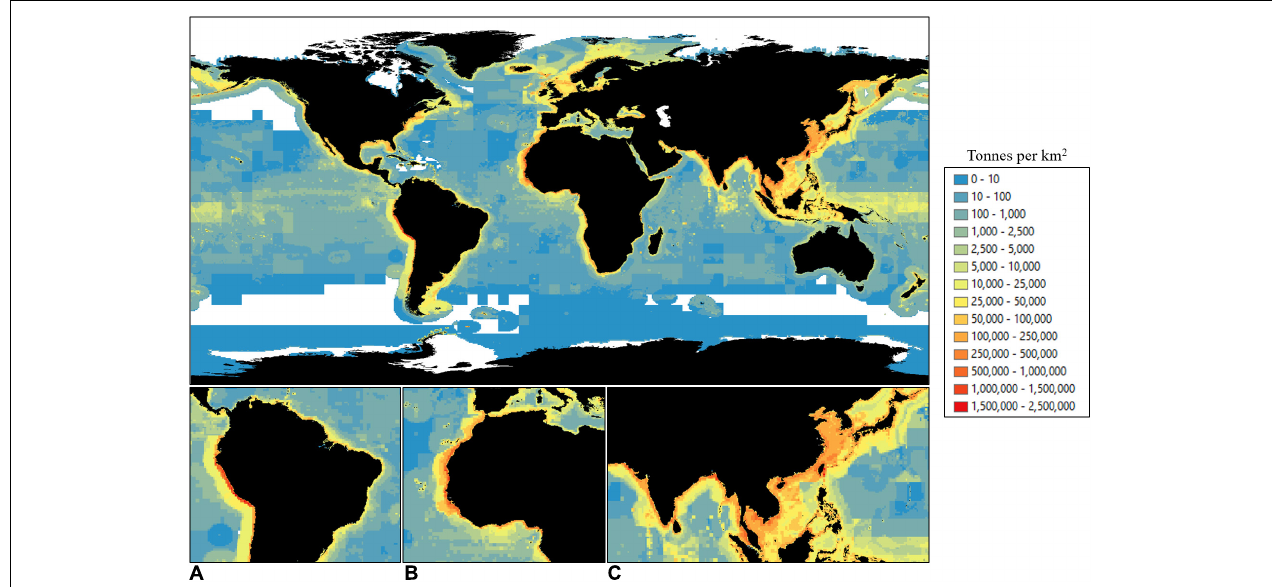
FIGURE 1 | Total summed catch (2009–2018) in tonnes per 0.5-degree cell [approx. 55 × 55 km 2 at the equator (data from the Sea Around Us , Pauly et al., 2020)]. Red: highest values; blue: lowest values; white: no data. Panel (A–C) insets denote areas of highest catch for (A) South America west coast, (B) West Africa, and (C) South and East